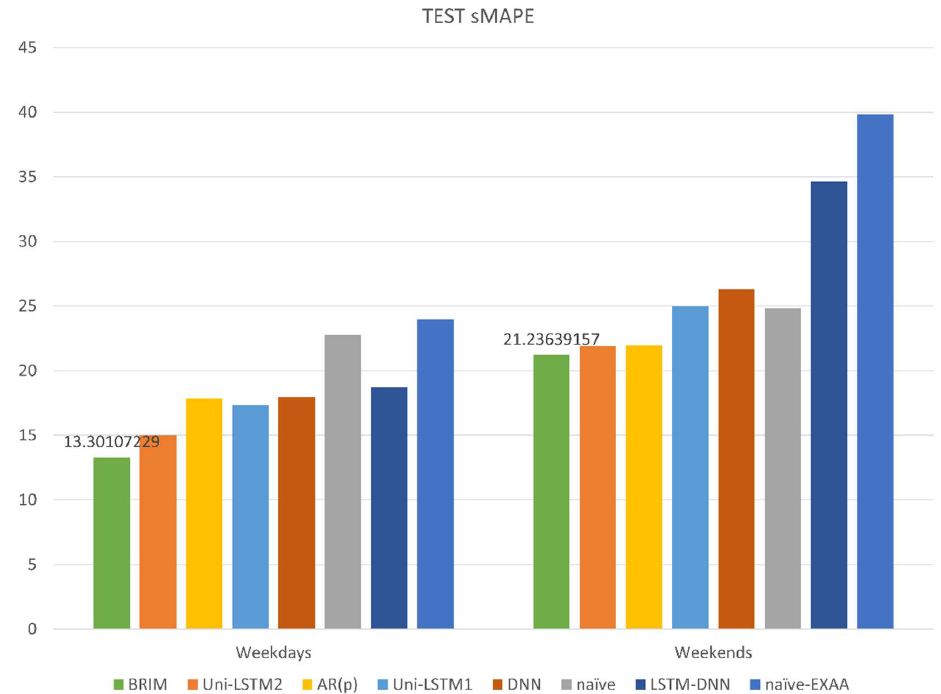
Figure 11. Comparison of predictive performance on weekdays and weekends by means of symmetric mean absolute percentage error (sMAPE).